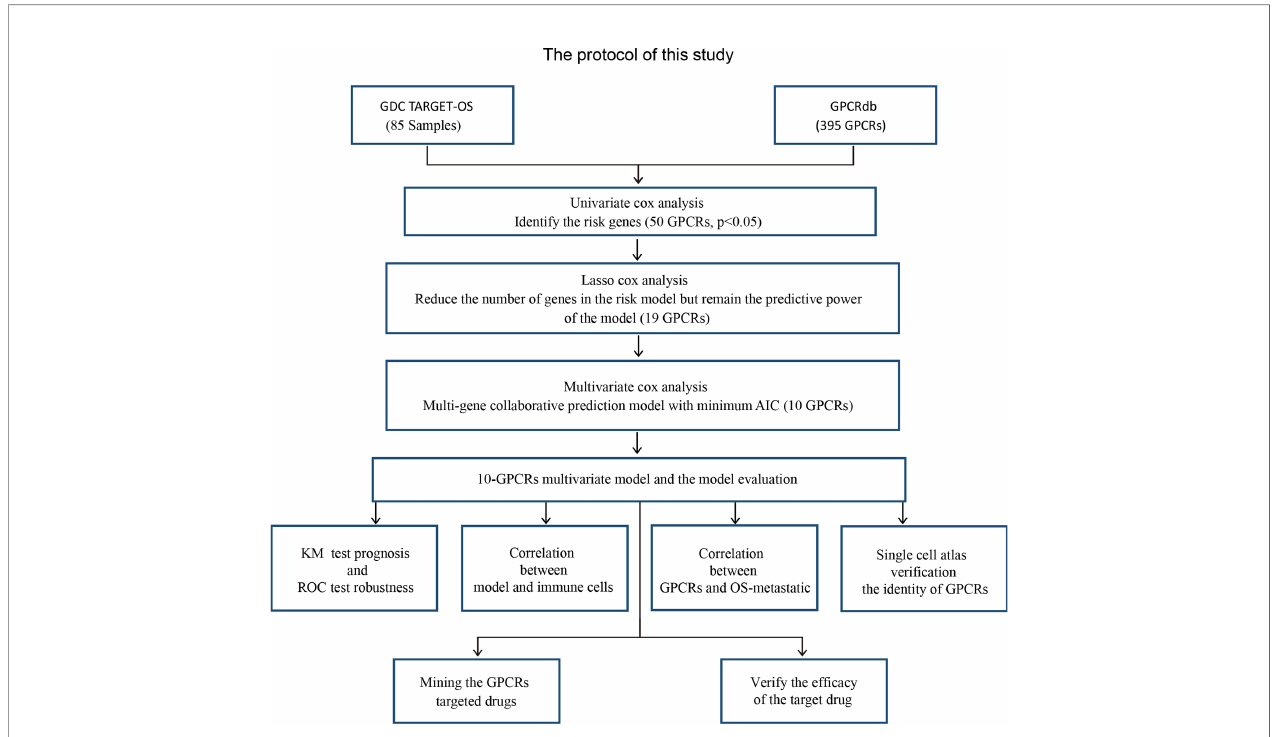
FIGURE 1 | The research protocol for the identi fi cation of OS risk-related GPCRs and discovery of their target drugs. GDC TARGET: “ Genomic Data Commons, Therapeutically Applicable Research To Generate Effective Treatments ” , GPCRdb, G protein-coupled receptor database; AIC, Akaike information criterion; KM, Kaplan – Meier